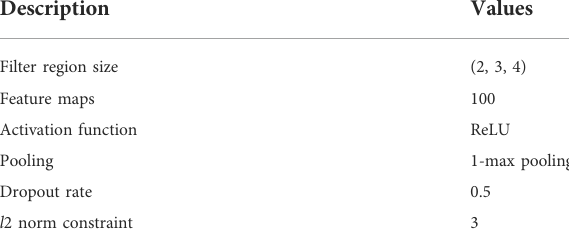
TABLE 1 Baseline con fi guration.